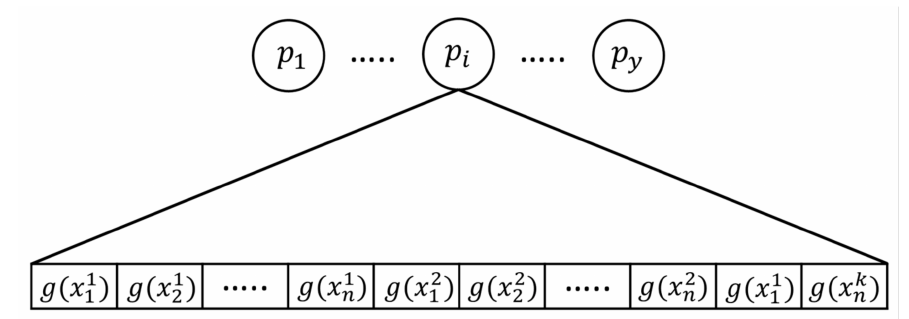
Figure 8. Encoding of